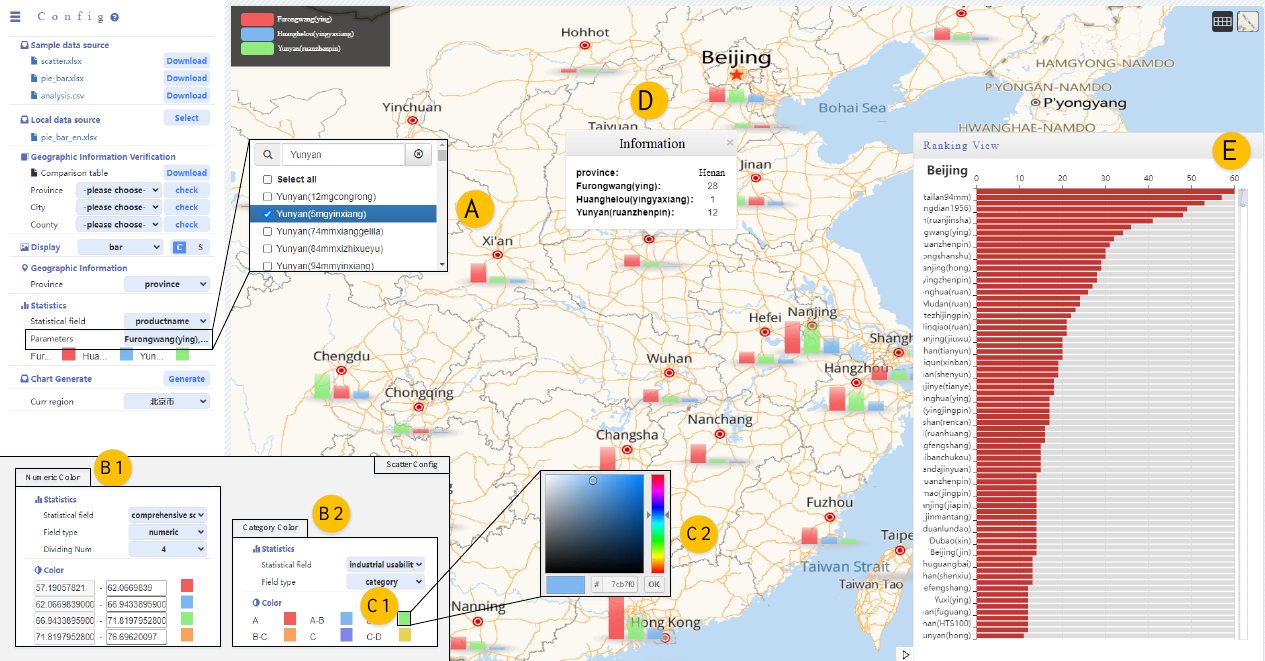
Figure 5. Spatial data visualization. The user can select parameters with multiple selectors ( A ). The color configuration scheme includes continuous data segmentation ( B1 ) and enumeration data color configuration ( B2 ). Configure the attribute color ( C1 ) using the color selector ( C2 ). Hover the mouse on the bar chart ( D ) to display details about a given region. The ranking view ( E ) shows the current attribute ranking in a given